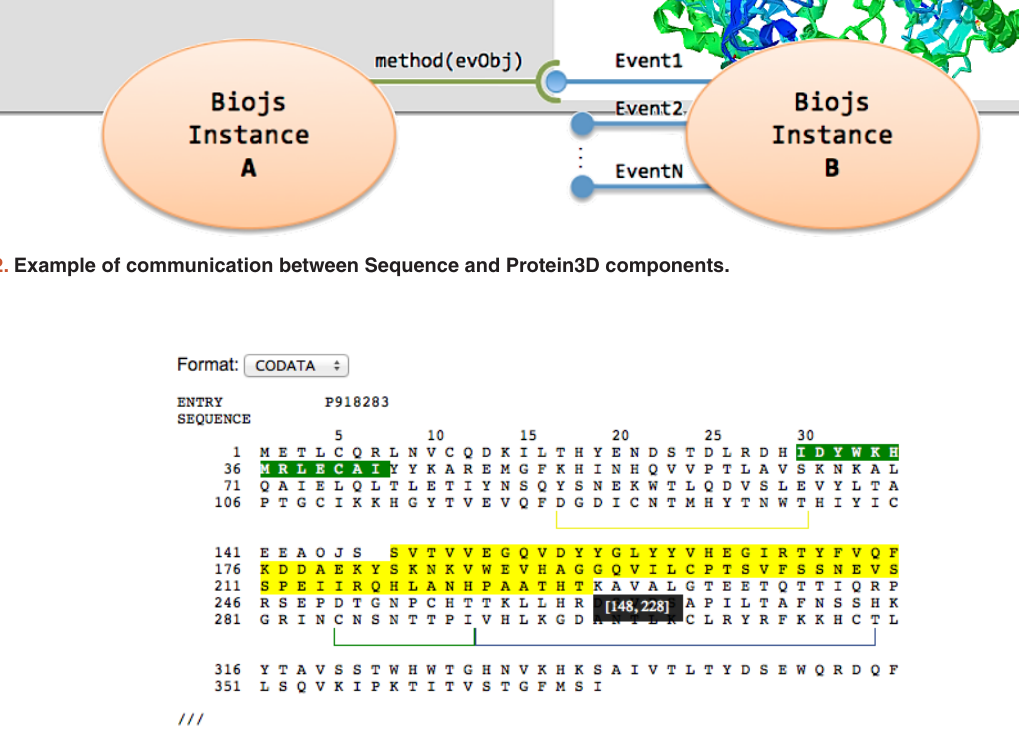
Figure 3. Example displaying the sequence corresponding to the UniProt accession P918283. The part highlighted in yellow denotes the current selection, the black pop-up box indicates what the interval is with every move of the pointer. Green highlight denotes an annotation on that interval. Multiple annotations are supported.